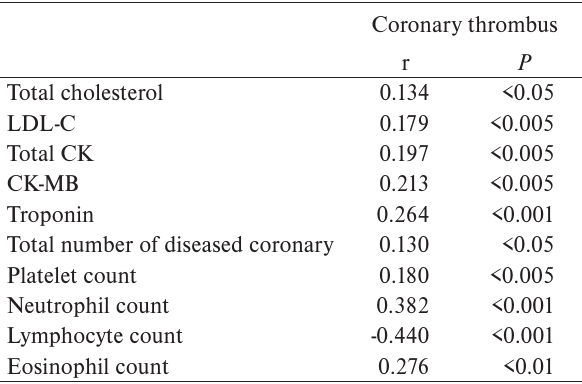
Table 3. Correlations between the coronary thrombus forma- tion and the patient